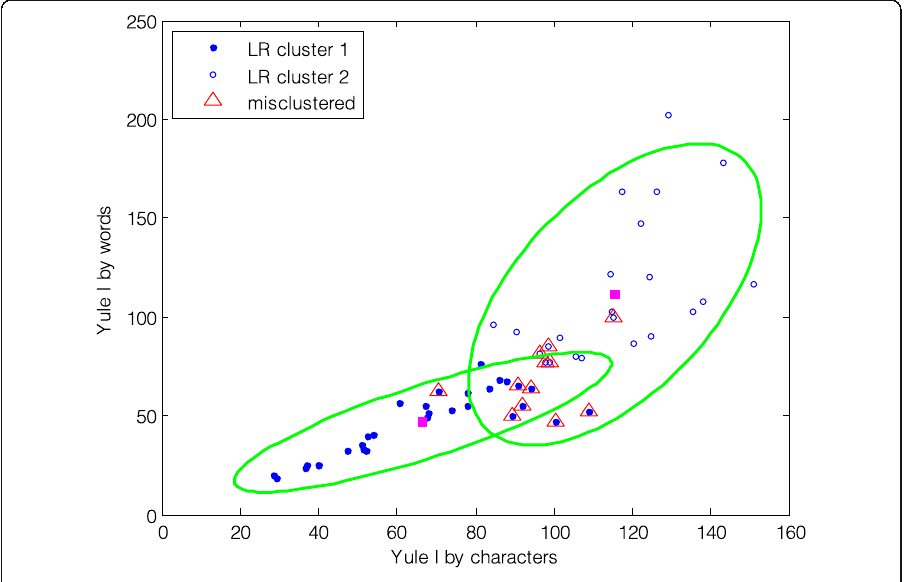
Fig. 3 Differentiation of L1 and L2 speakers using LR measure Yule